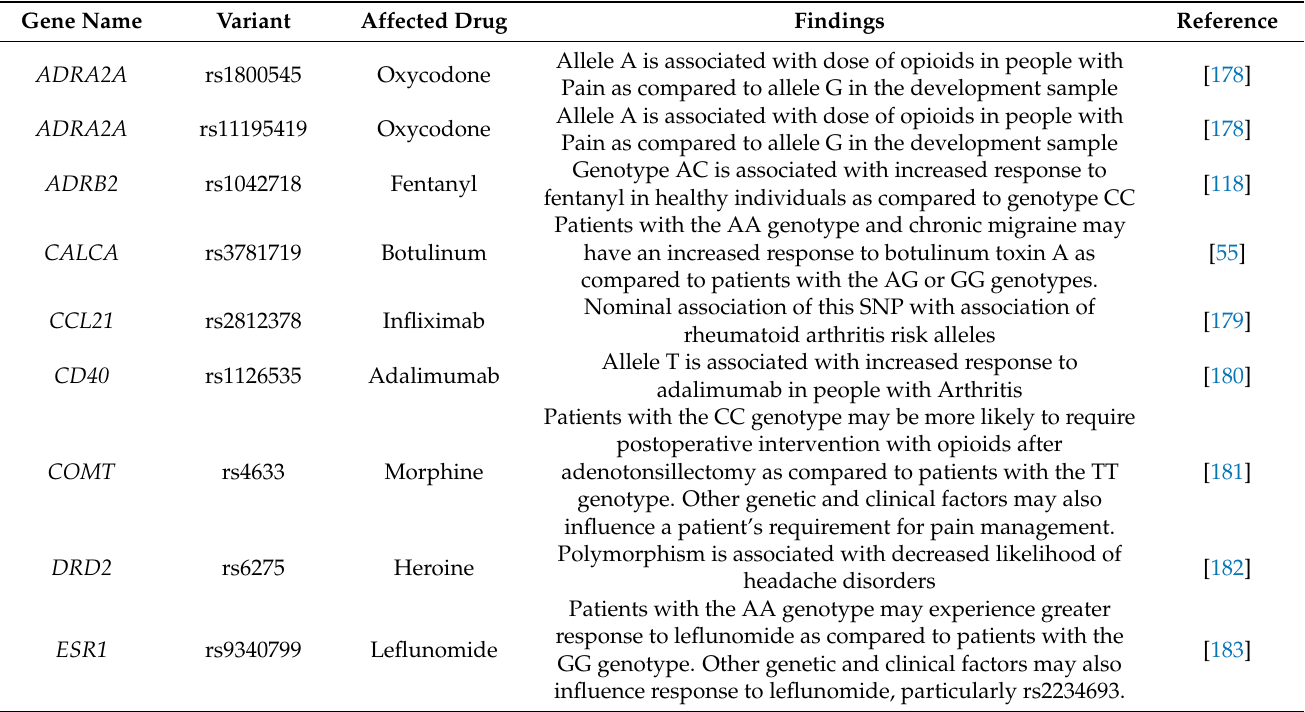
Table 3. Gene variants with reported pharmacogenetic effects. The table provides a summary of variants in genes included in the proposed panel of n = 72 genes and found in the DNA of the 61 analyzed subjects, that have been implicated in a pharmacogenetic context to modulate the effects of drugs administered for the treatment of pain or as disease modifying therapeutics in a painful